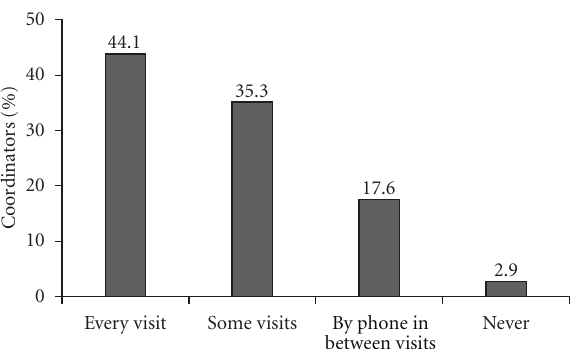
F 1: Frequency of patient questions regarding immunosup- pressant therapy.